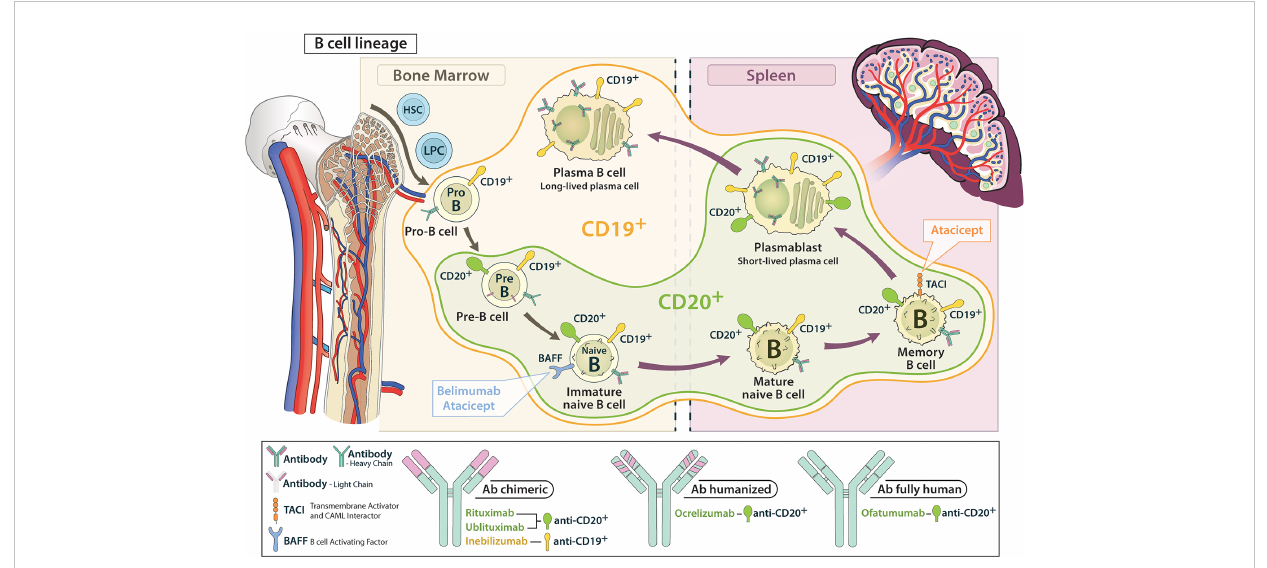
FIGURE 3 Schematic representation of the attack range of CD 19 and CD 20 antibodies in the B cell lineage. CD 19 antibodies cover earlier and later developmental stages compared to CD 20